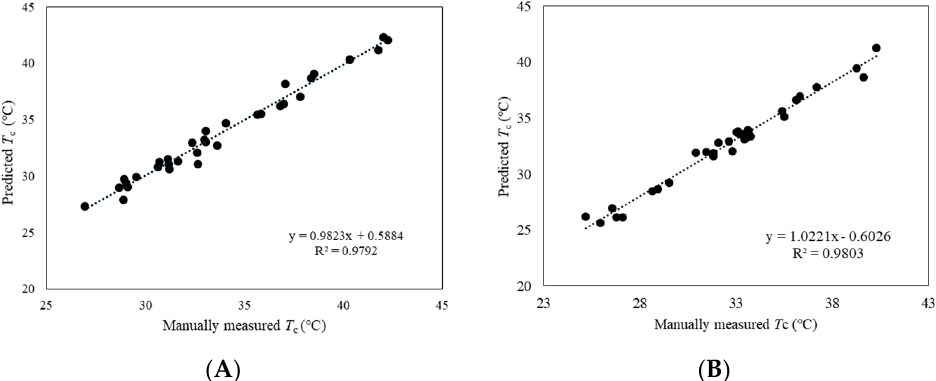
Figure 4. Performance of the proposed imaging processing algorithm for average T c calculation relative to the manually measured T c in the ( A ) shaded side and ( B ) sunlit side of vine canopies.